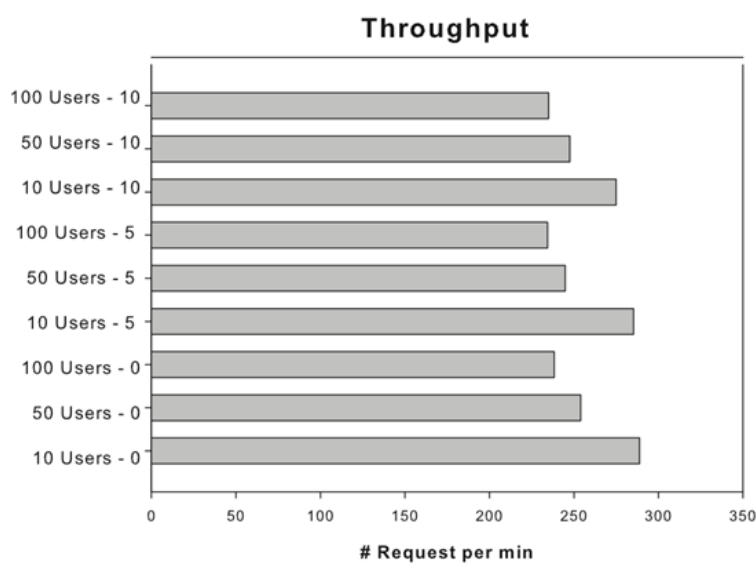
Figure 8. Obtained throughput results for different combination of